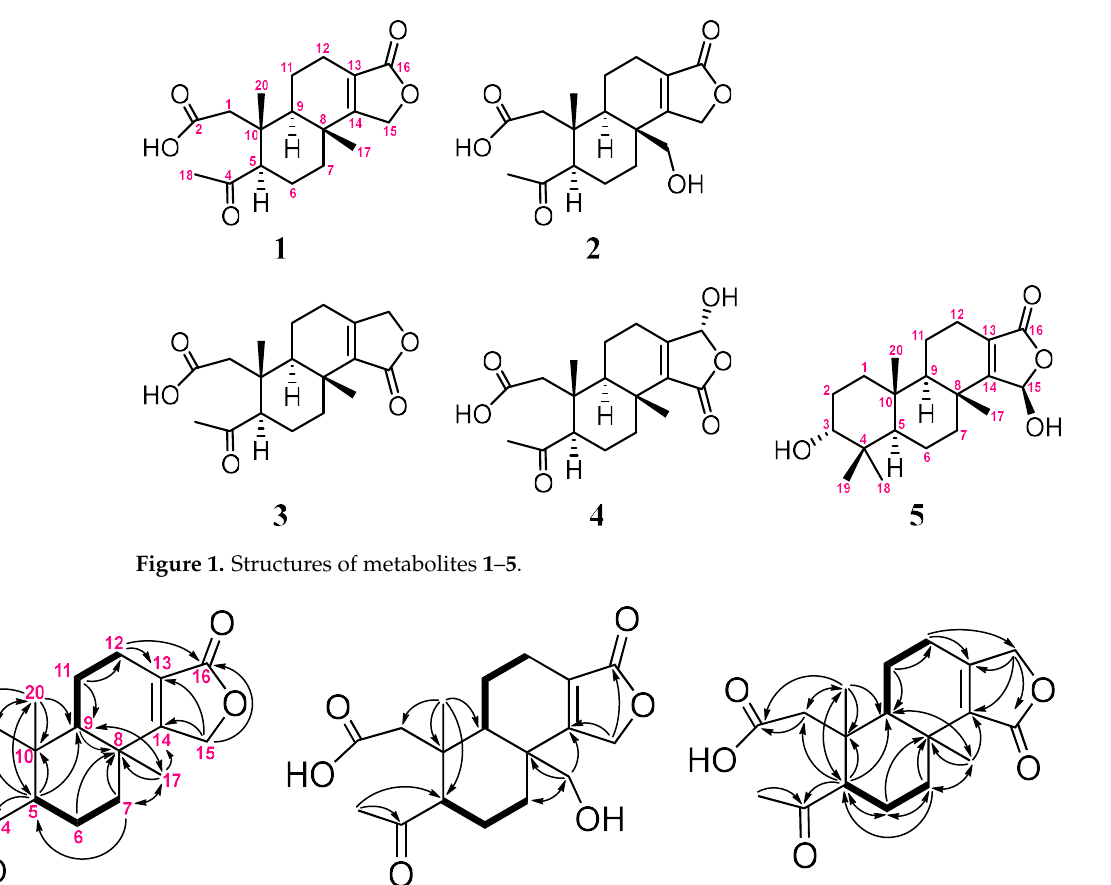
Figure 3. The key NOESY ( ↔ ) correlations of 1 – 5 .